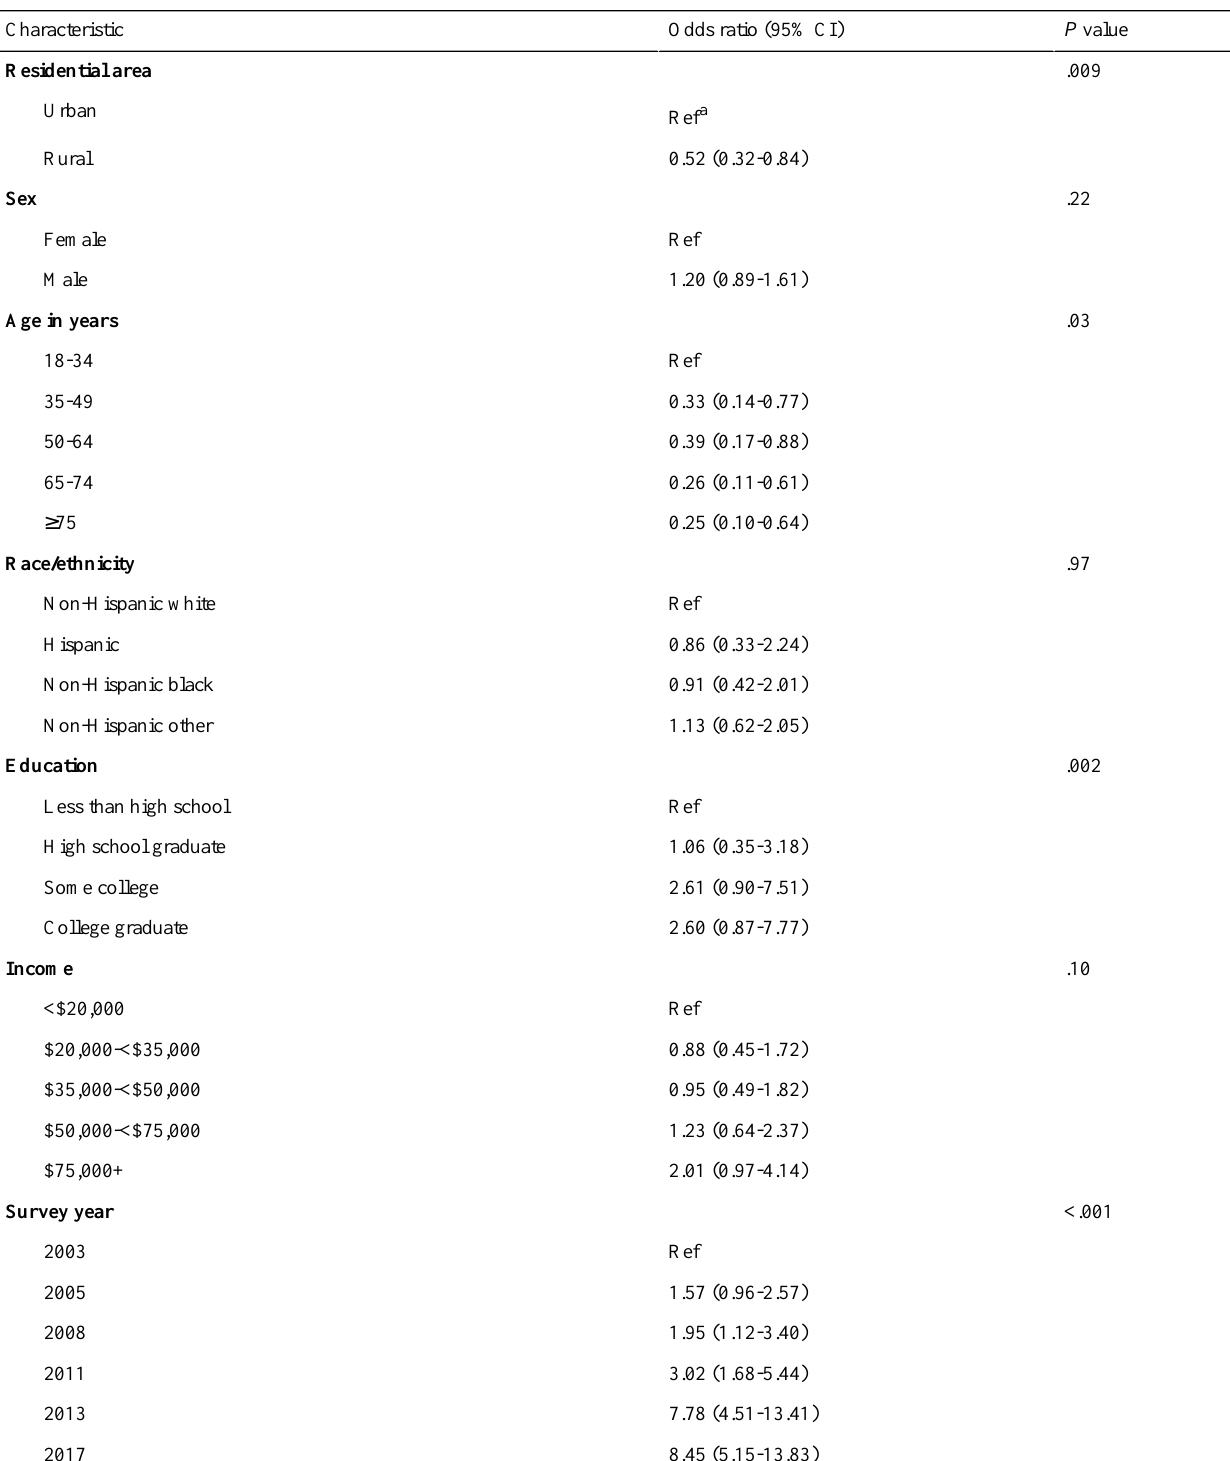
Table 3. Logistic regression model of email communication between patients who reported being diagnosed with cancer and health care provider grouped by rural/urban status based on responses from the Health Information National Trends Survey (n=2058) in the years 2003, 2005, 2008, 2011, 2013, and 2017. Adjusted for gender, age, race/ethnicity, education, and